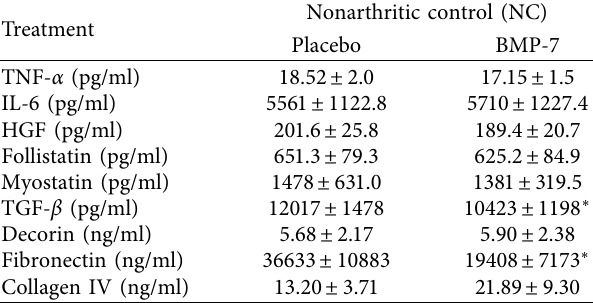
Figure 8: Triple culture supernatant extracellular matrix factor concentrations comparing healthy (NC), RA treatment-na¨ıve (RATN), and RA treatment-nonresponding (RATNR) patients. (a) TGF β ; (b) decorin; (c) fibronectin; (d) collagen 1a1; (e) collagen IV. Statistical analysis: one-way ANOVA (parametric: (a, b, c, d) or Kruskal–Wallis test (nonparametric: e). ∗ � p < 0 . 05; ∗∗ � p < 0 . 01; ∗∗∗ � p < 0 . 001. n � 6 per group. Data represented as mean ± SD. TGF β � transforming growth factor- β ; BMP-7 � bone morphogenetic protein 7. Table 1: Comparison of the concentrations of cytokines and growth factors in the triple coculture exposed to NC patient serum after being treated with placebo or BMP-7. Data represented as mean ± SD. ∗ � p < 0 . 05. n � 6 per group. TNF- α � tumour necrosis factor- α ; IL � interleukin; HGF � hepatocyte growth factor; TGF- β � transforming growth factor- β